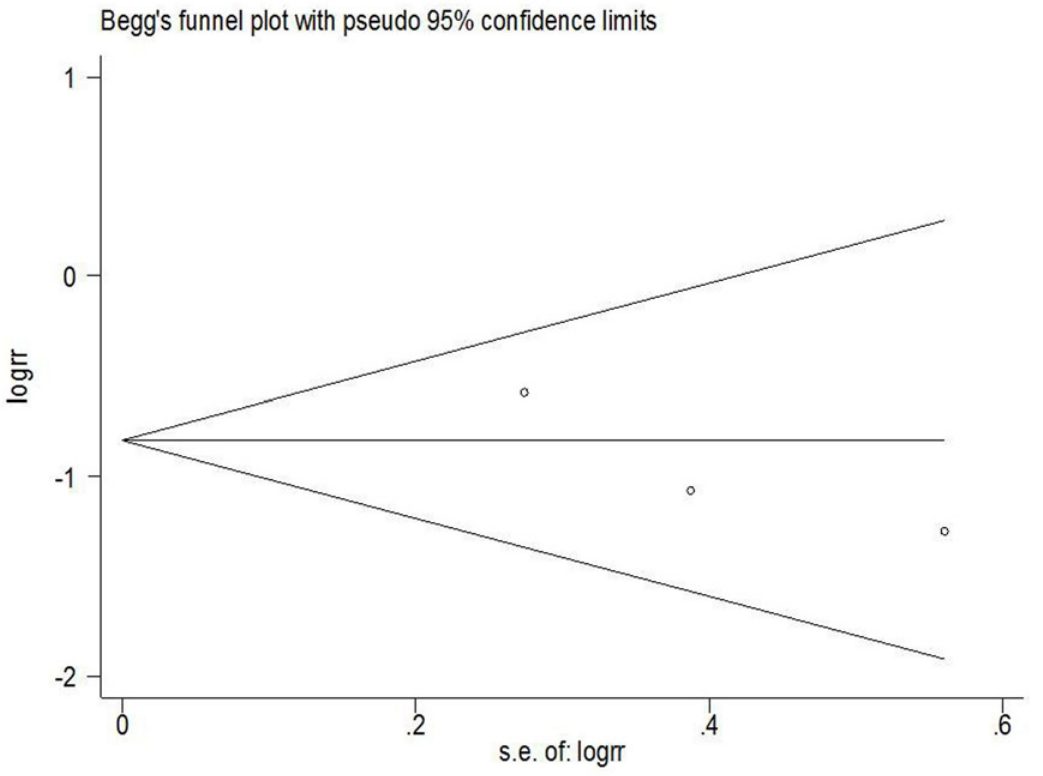
Fig 4. A funnel plot analysis on the detection of publication bias in the meta-analysis of the prognostic value of p16ink4a in the OS of vulvar